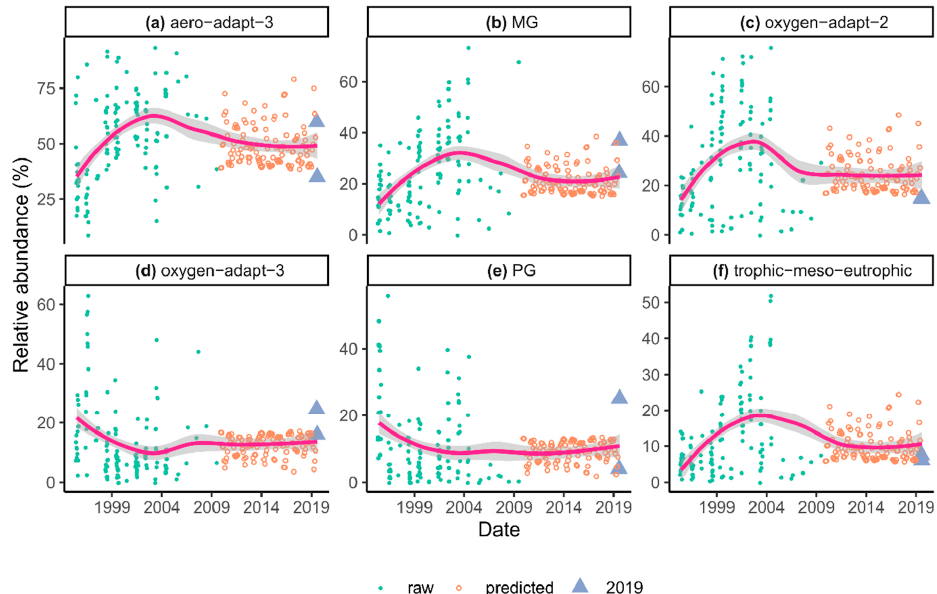
Figure 14. Relative abundance of significant traits of the diatom assemblage on deployed and natural reeds at c5 and c6 sampling points of the Cikola tributary system. Relative abundance is calculated using the model for missing period in the function of water discharge and LOESS (locally estimated scatterplot smoothing) curve is fitted to them. (See Figure 9. and text for abbreviations).